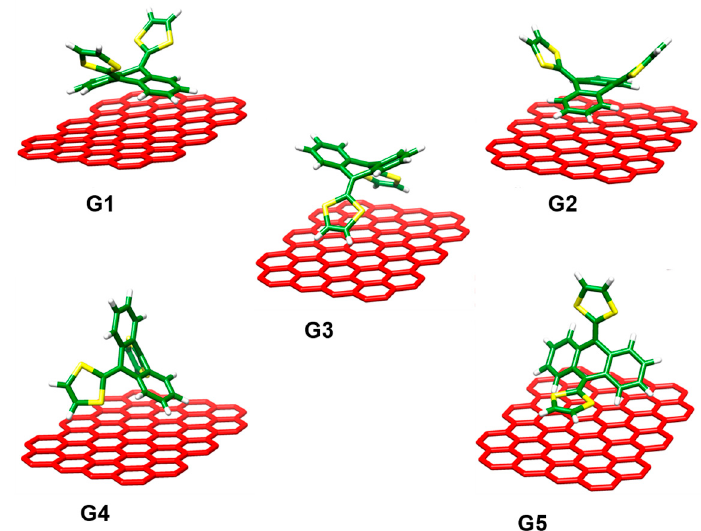
Figure 27. Minimum-energy structures computed for the exTTF-graphene models ( G1 – G5 ) at the revPBE0-D3/cc-pVDZ level. Carbon atoms of exTTF are depicted in green, sulfur in yellow and hydrogen in white. Carbon atoms of the graphene sheet are depicted in red and hydrogen atoms have been omitted for clarity. Adapted with permission from [120]. Copyright 2013 WILEY-VCH Verlag GmbH & Co. KGaA.